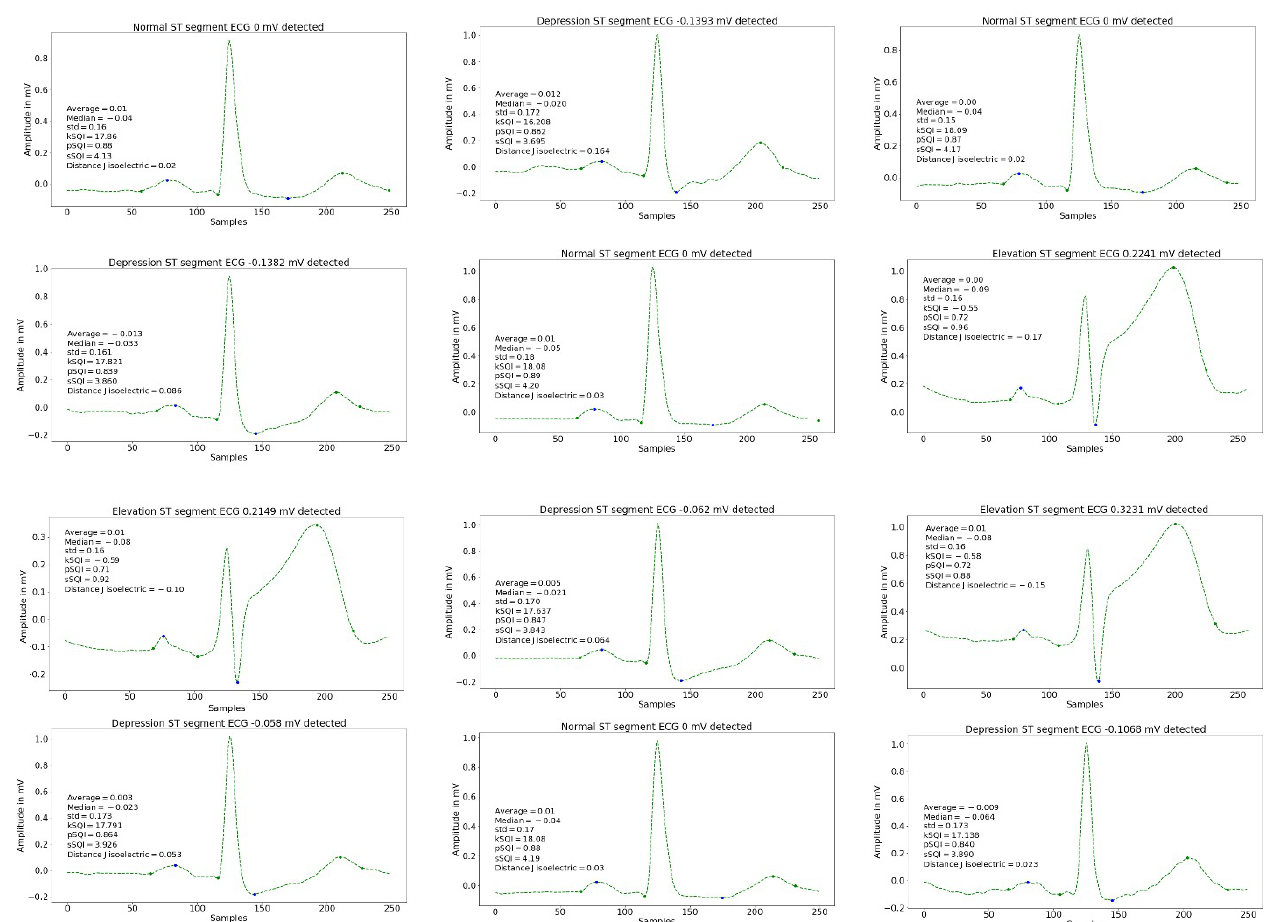
Figure 16. Result in the regression task used for this approach. Detection of several ECG beats, some of them categorized as normal, depressed or